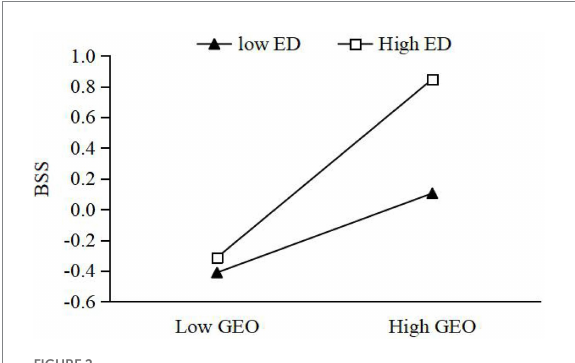
FIGURE 2 Moderating effect of environmental dynamism (ED) between green entrepreneurial orientation (GEO) and boundary-spanning search